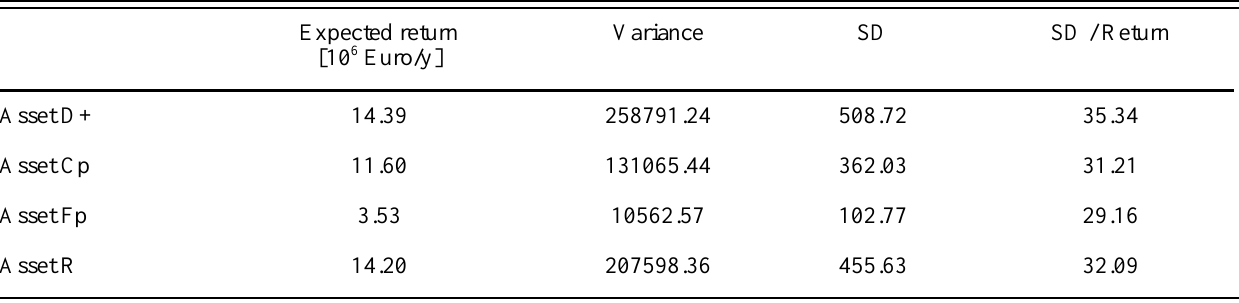
Table 2. Expected return, variance, and standard deviation (SD) per asset under the current climate